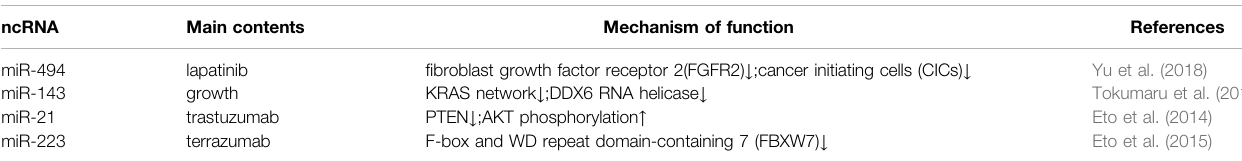
TABLE 3 | NcRNAs in HER2-positive